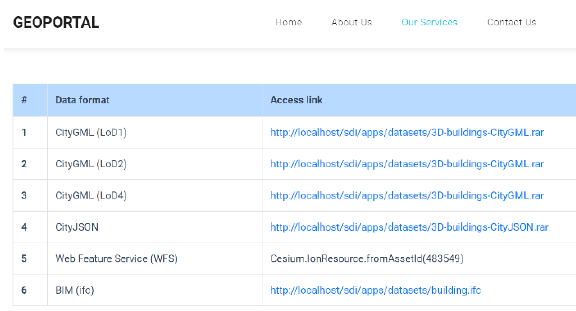
Figure 7 . A list of available 3D data formats can be download from the geoportal.